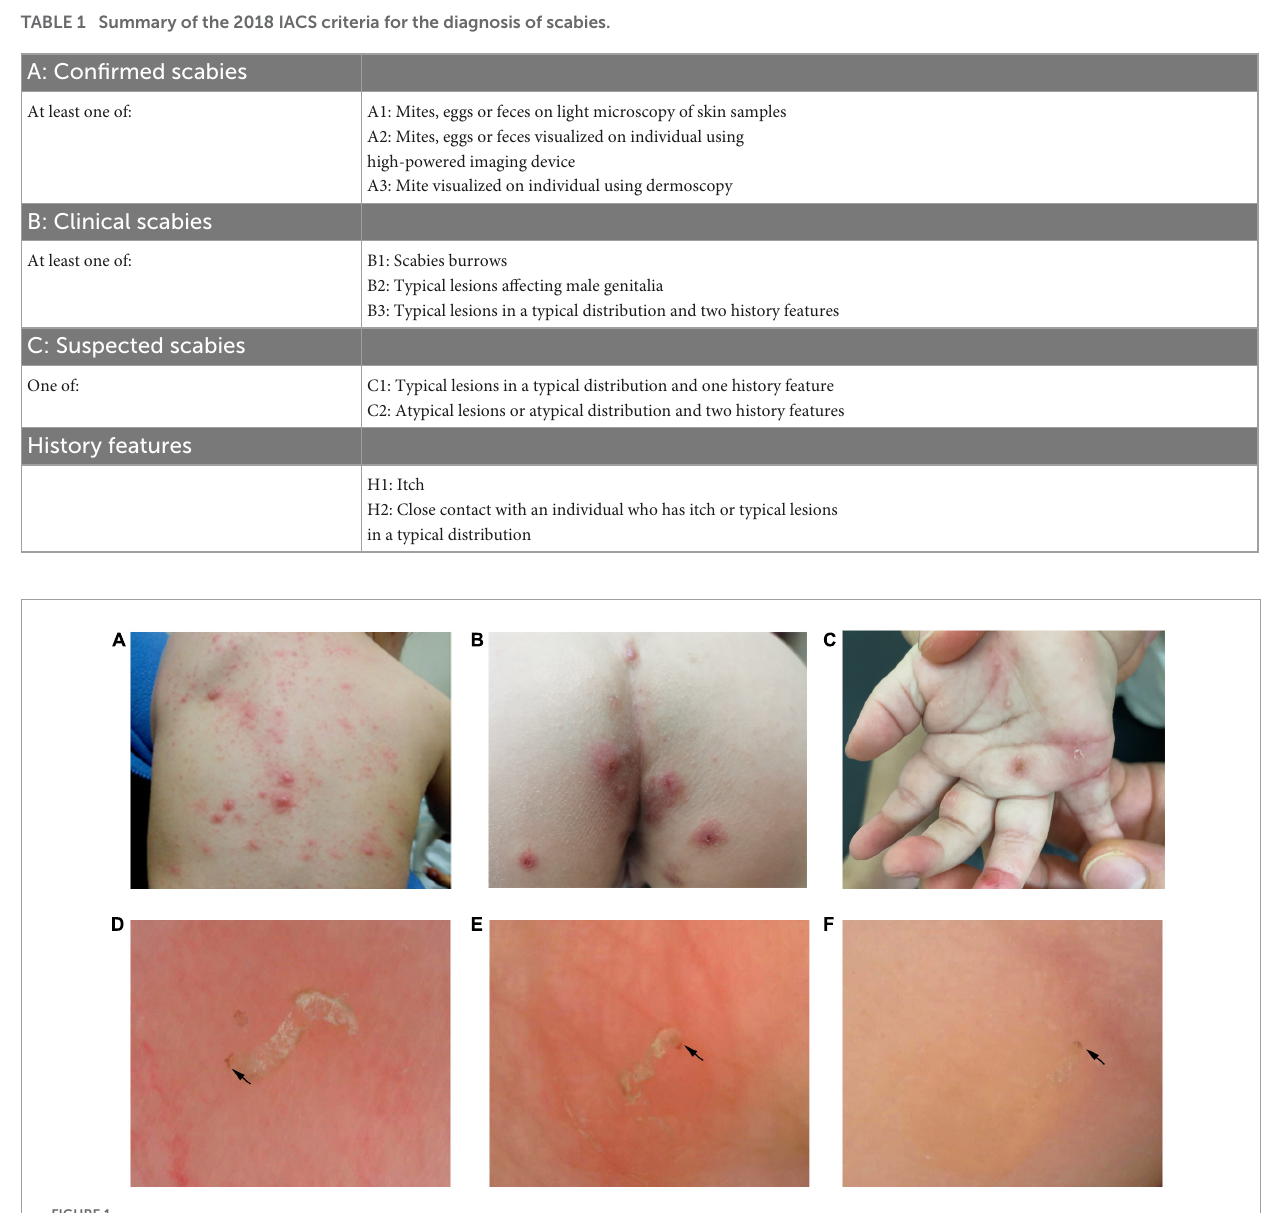
TABLE 1 Summary of the 2018 IACS criteria for the diagnosis of scabies.